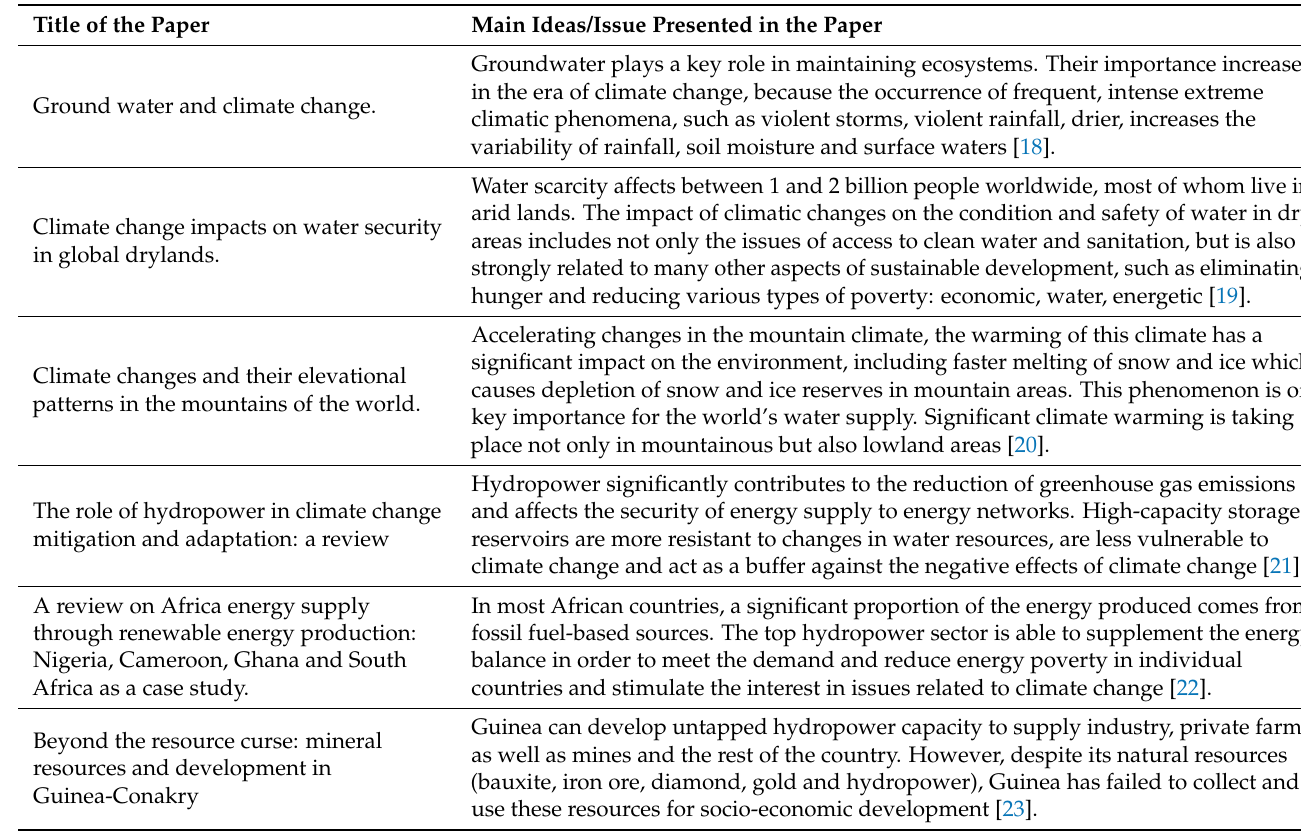
Table 1. Selected papers concerning climate change, water issue and hydro